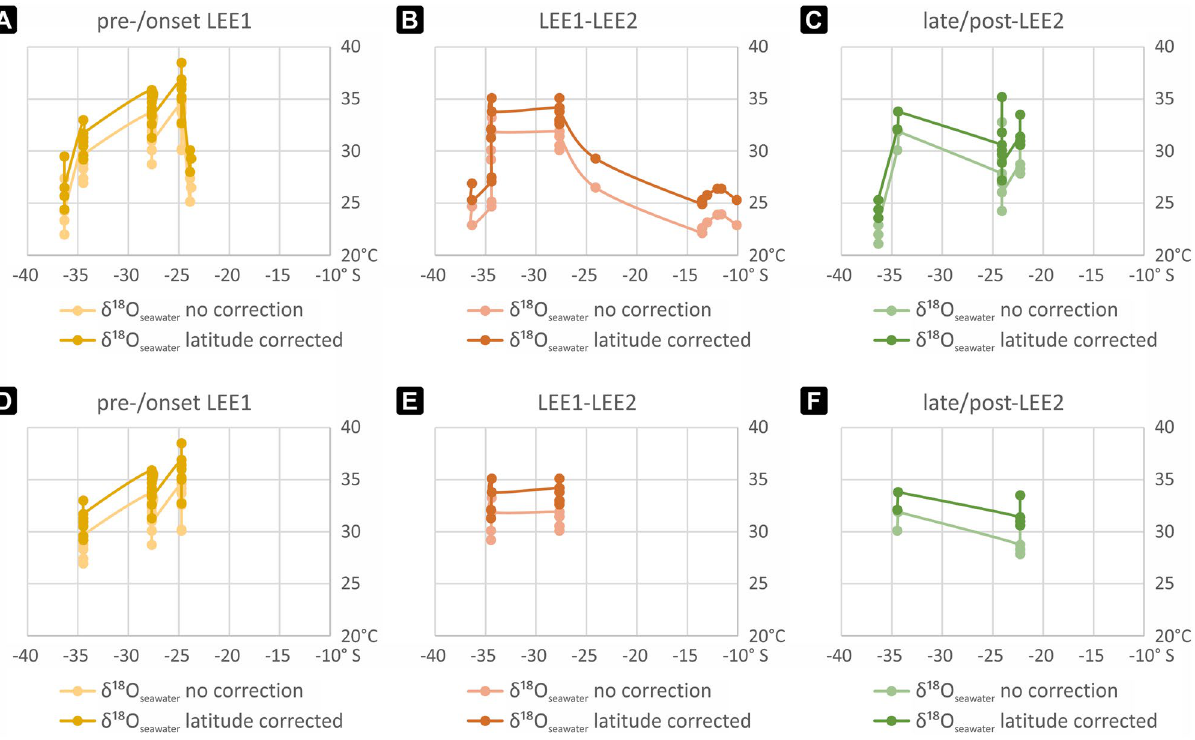
Figure 4. Comparison of paleotemperatures calculated from δ 18 O apatite assuming δ 18 O seawater = − 1‰ VSMOW vs. applying a latitude correction for δ 18 O seawater during the ( A , D ) pre-/onset LEE1 ( kockelianus Biozone), ( B , E ) LEE1–LEE2 ( ensensis Biozone) and ( C , F ) late/post-LEE2 ( hemiansatus Biozone). ( A – C ) Entire dataset. ( D – F ) Shallow marine localities excluded. x-axis: southern hemisphere latitude; y-axis: temperature in